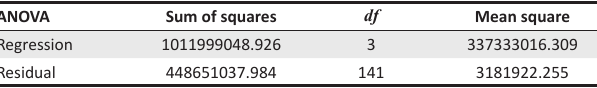
TABLE 6: Analysis of variance – Short-term incentive. Analysis